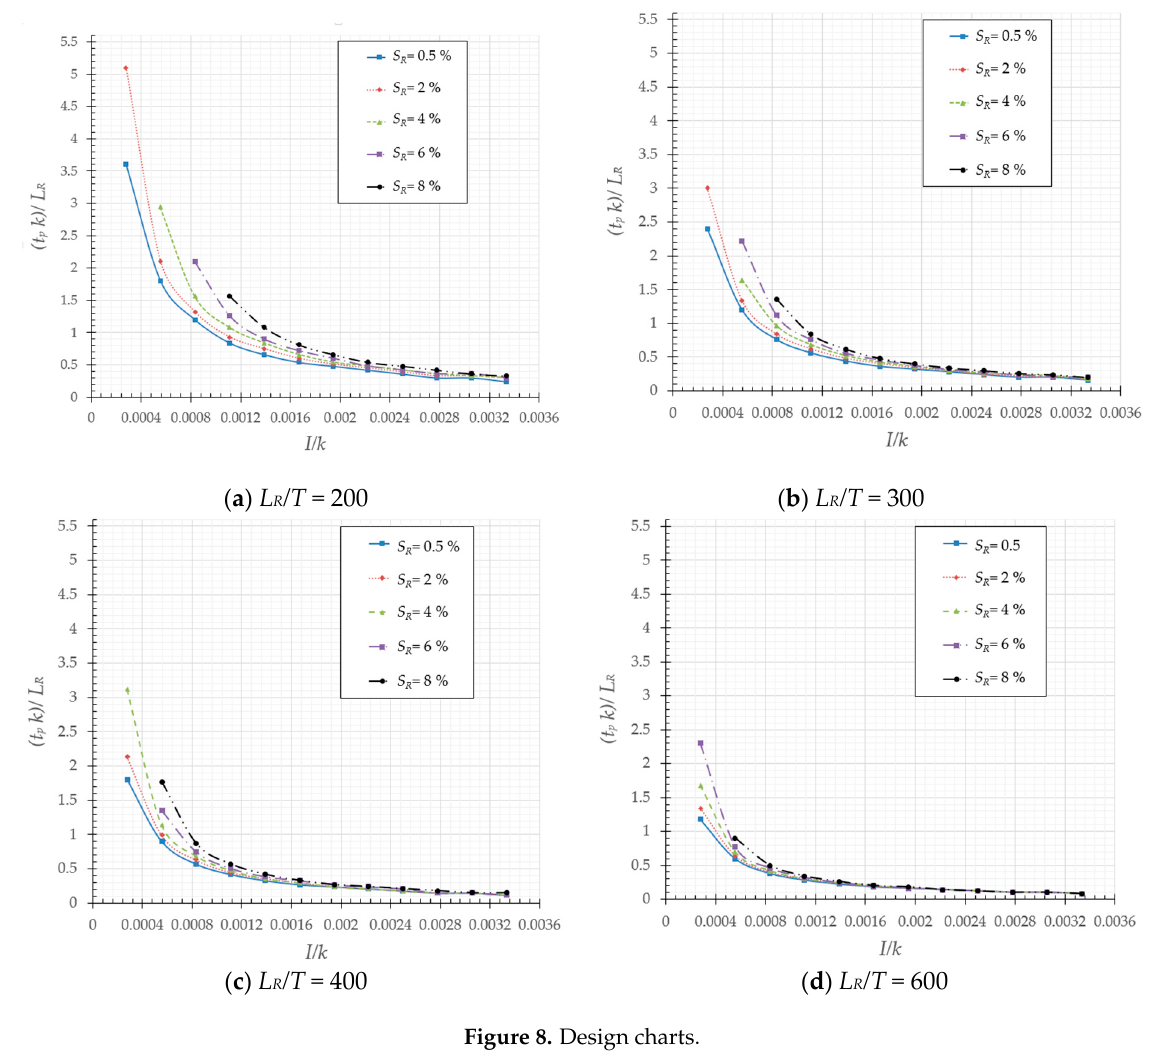
Figure 8. Design charts.